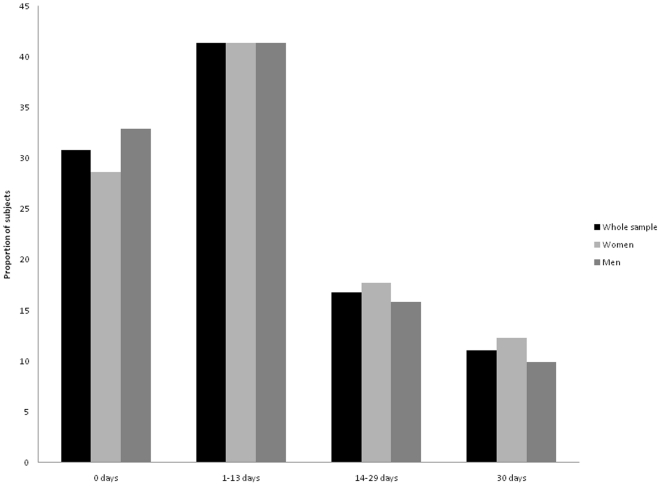
Insufficient rest or sleep among US adults.X-axis: Categories of insufficient rest or sleep in the past month. Y-axis: Weighted proportion (%) of subjects within each insufficient rest/sleep category.